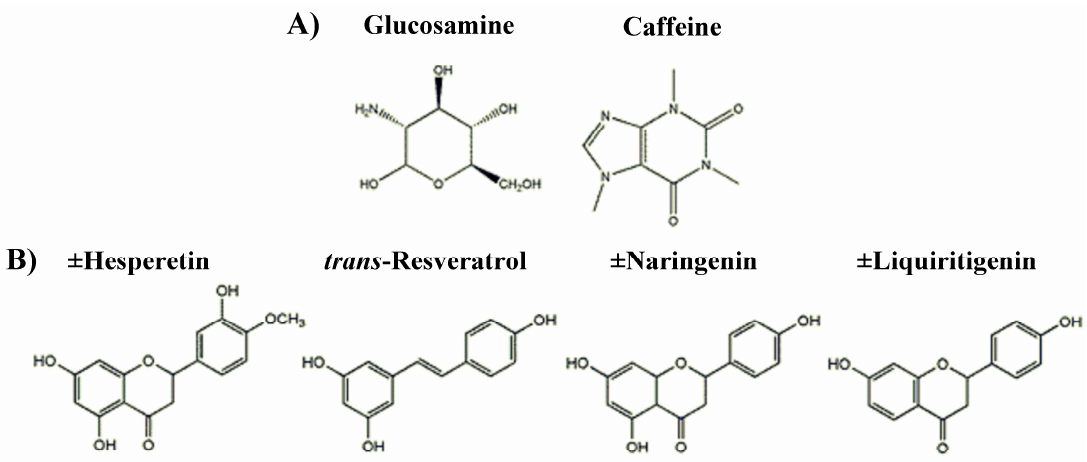
Figure 1. ( A ) Chemical structures of glucosamine and the internal standard caffeine; ( B ) chemical structures of ± hesperetin, ± naringenin, trans -resveratrol and the internal standard ±